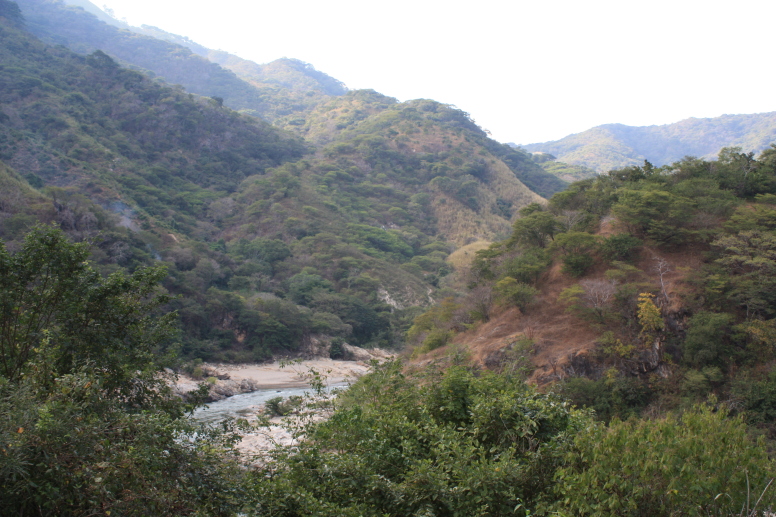
Brachypelma
verdezi habitat, subtropical dry forest and scrubland, near Acapulco, Guerrero state, Mexico. Photo: Stuart J. Longhorn.